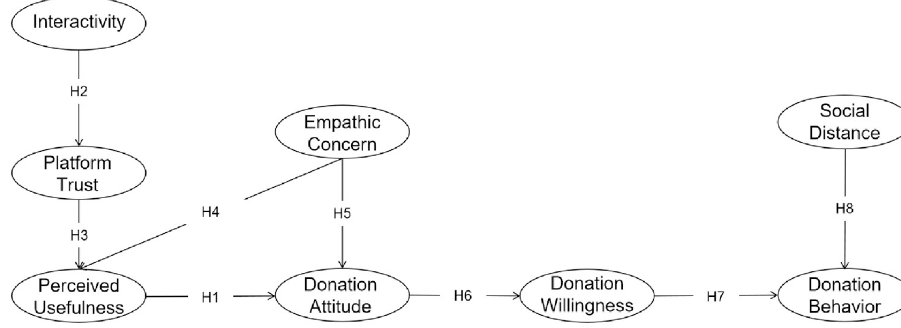
Fig 2. Diagram of the proposed